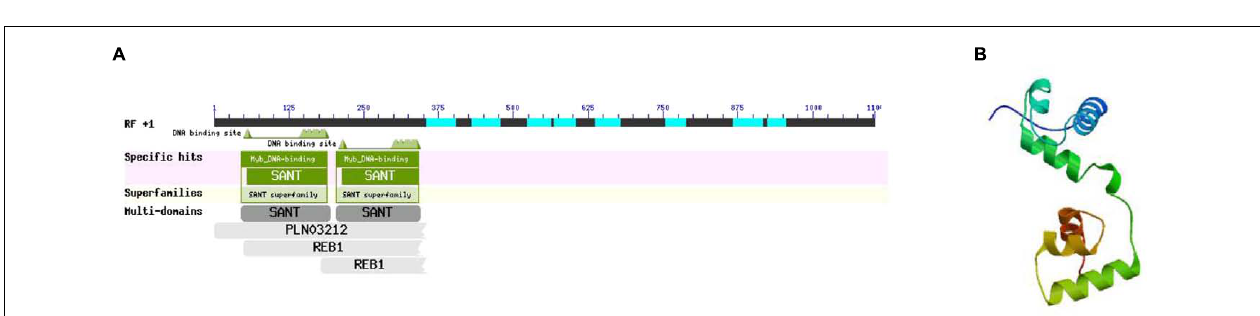
FIGURE 12 | Structural domain (A) and tertiary structure (B) of MYB-related protein p-1.